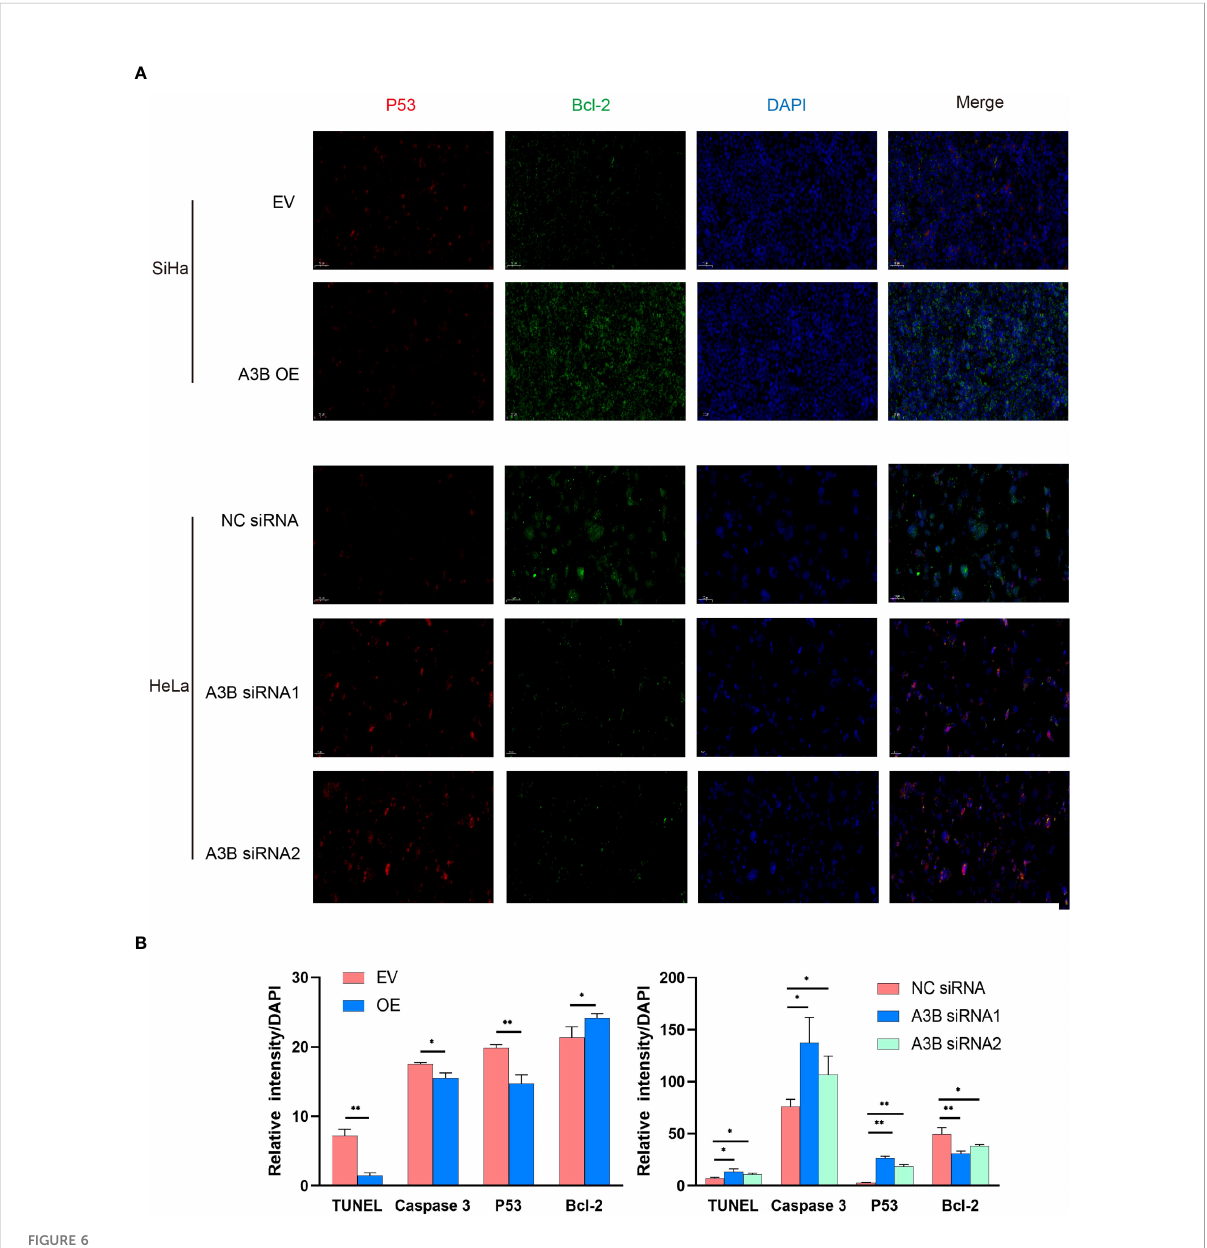
FIGURE 6 Relationship between p53, Bcl2, and protein expression of A3B. (A) Representative image of fl uorescence. Red represents p53, green represents Bcl-2, and blue represents DAPI. A3B correlates inversely with the expression of p53 and positively with Bcl-2 in cervical cancer. (B) Quanti fi cation of immuno fl uorescence data. * p < 0.05; ** p <